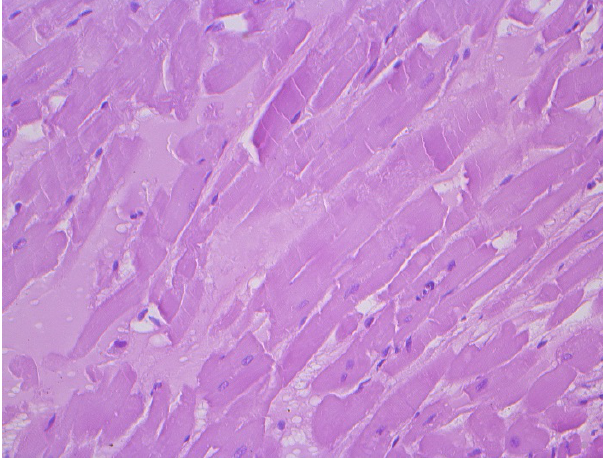
Fig. 6. Myocardium. Granular-deep decay of cardiomyo- cytes. McManus. EP. 10, lens. 40